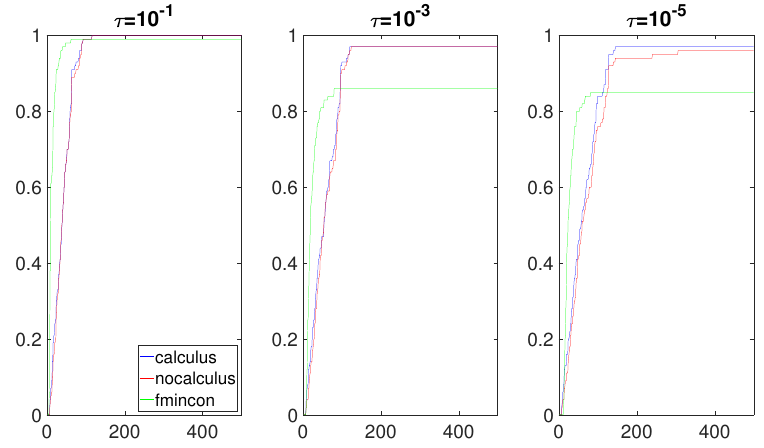
Figure 3. Data profiles when F = f 1 · f 2 and when f 1 , f 2 are quadratic functions.